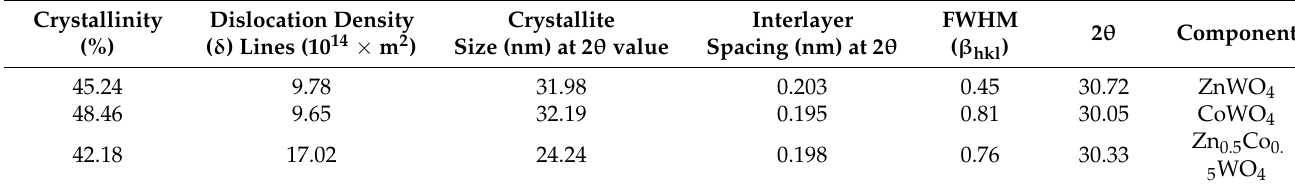
Table 1. XRD parameter of ZnWO 4 , CoWO 4, and Zn0.5Co0.5WO 4 .